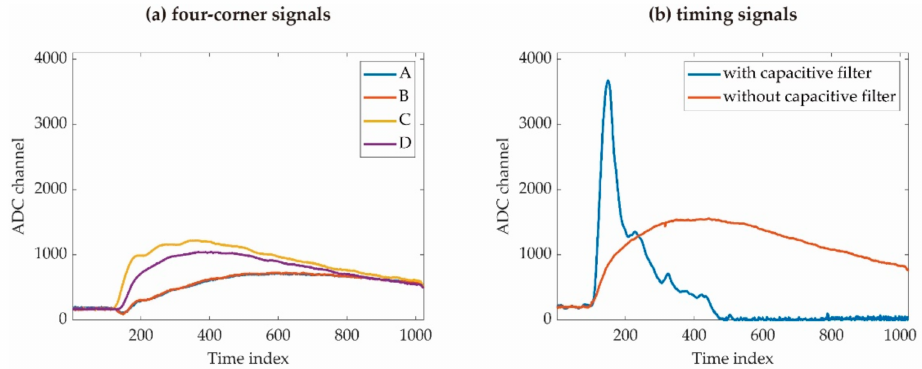
Figure 4. Waveforms of the ( a ) four-corner signals, and ( b ) timing signals after amplified by non- inverting amplifier as shown in Figure